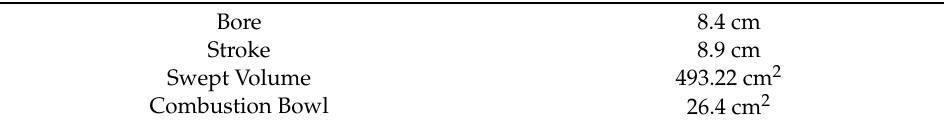
Table 1. Computation domain dimensions.